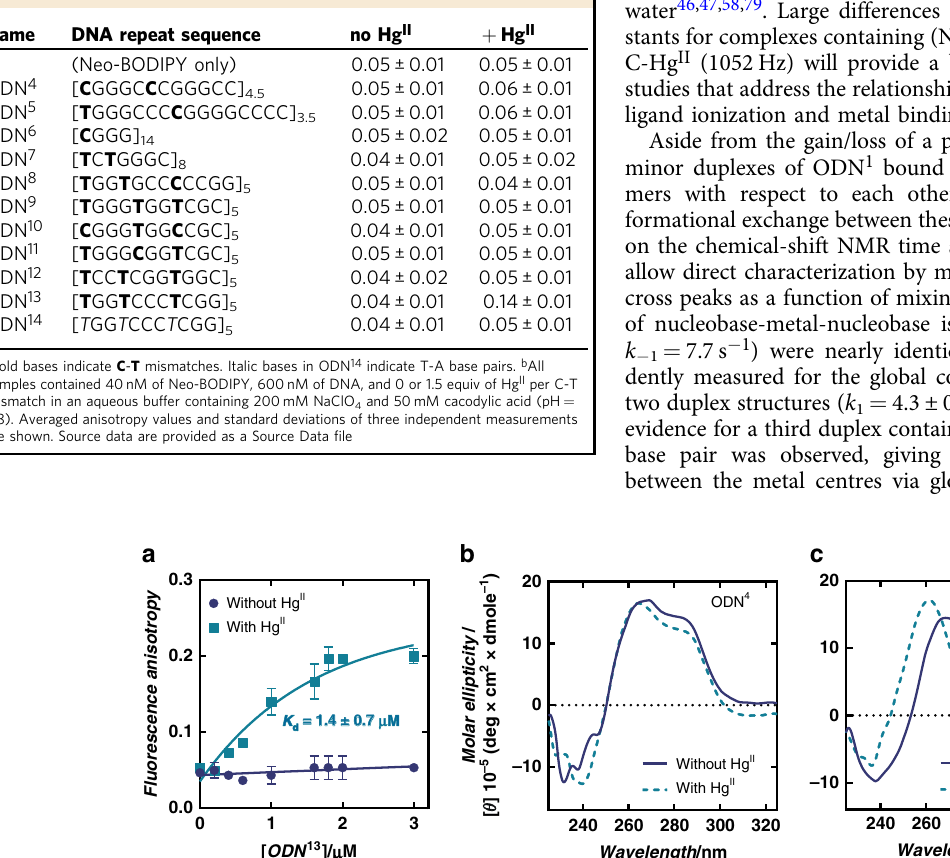
Fig. 8 Fluorescence anisotropy and CD spectra reveal global B-form to A-form helical transition upon addition of Hg II . a Changes in fl uorescence anisotropy ( λ ex = 480 nm, λ em = 515 nm) of Neo-BODIPY (40 nM) upon addition of hairpin ODN 13 prepared in the presence (light blue) and absence (dark blue) of Hg II . The values represent mean and standard deviation of three independent measurements. C-Hg II -T base pairs were formed by pre-incubation of the DNA with 1.5 equiv Hg II for 3 h prior to addition of Neo-BODIPY. b CD spectra of hairpin ODN 4 (1 μ M), or, c CD spectra of hairpin ODN 13 (1 μ M) in